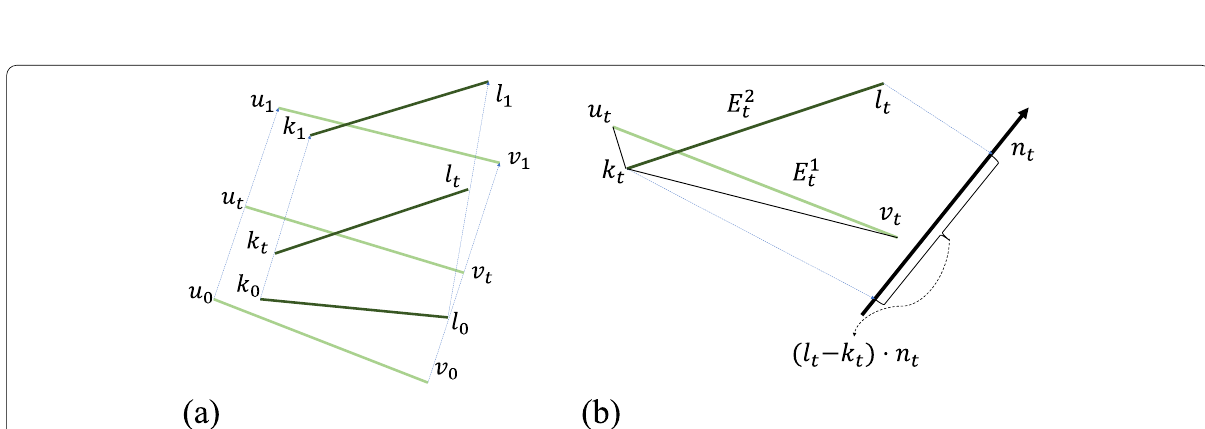
Fig. 4 Edge‑edge test: To perform an edge‑edge test between the two edges E 1 and E 2 (defined by u 0 , v 0 , and k 0 , l 0 at t t 1), the coplanarity conditions of these vertices by finding a t ( t = and v t is equal to zero, that is, ( l t